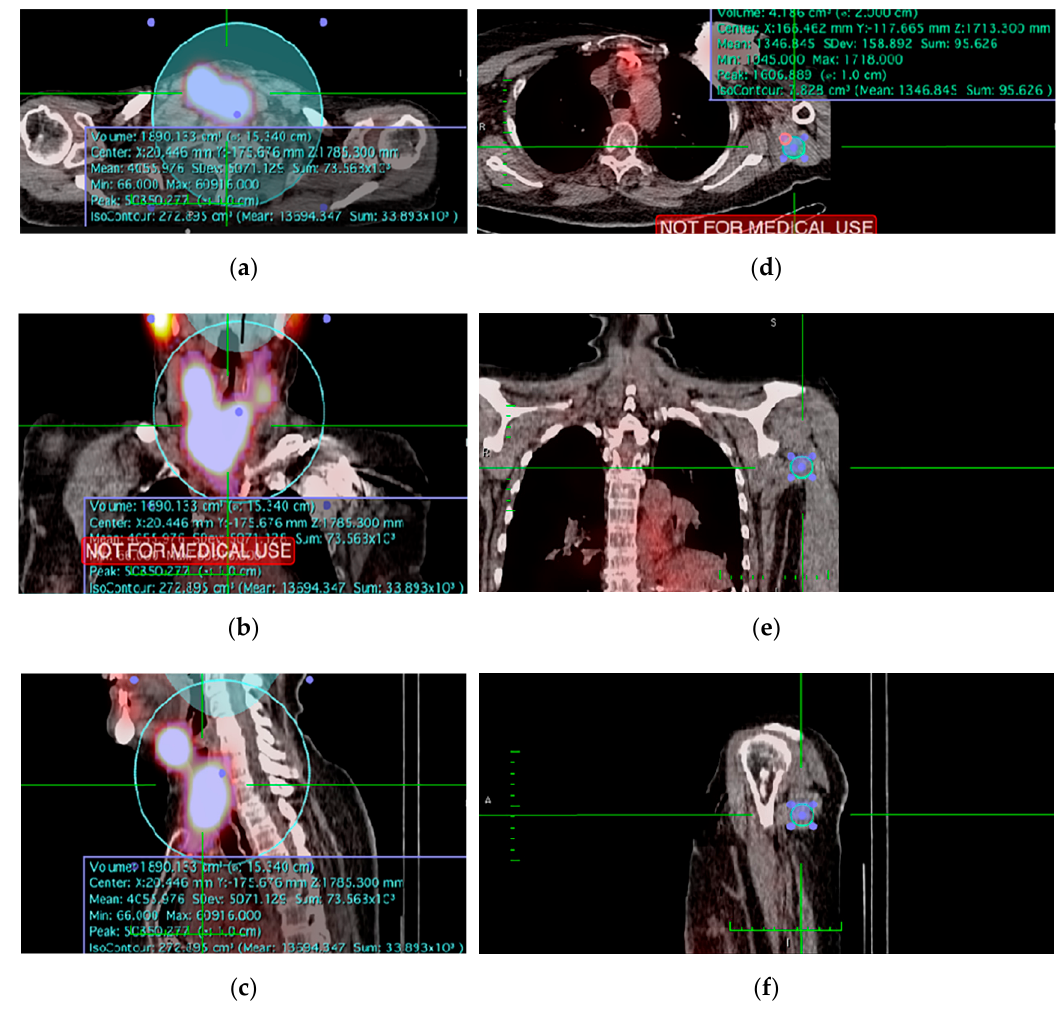
Figure 2. Example measurement of the thyroid remnant and shoulder volume-of-interest (VOI) on SPECT/CT: ( a – c ) Trans- verse, coronal and sagittal image of the semi-automatically drawn isocontour-based thyroid remnant VOI; ( d – f ) Transverse, coronal, and sagittal image of the predefined fixed-volume spherical background VOI (ø 20 mm) in the shoulder.